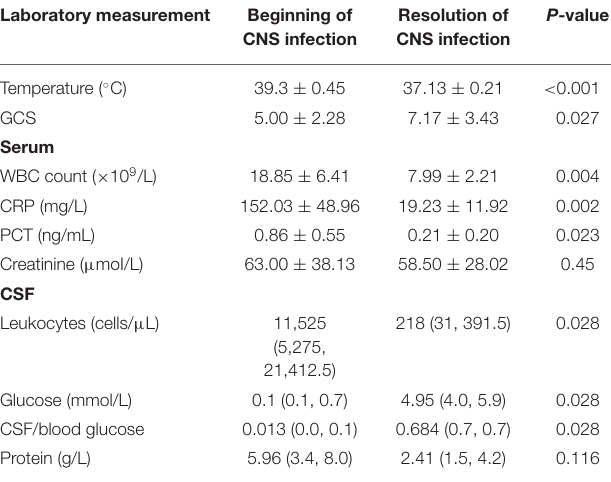
TABLE 4 | Clinical symptoms and laboratory data in patients. Laboratory measurement